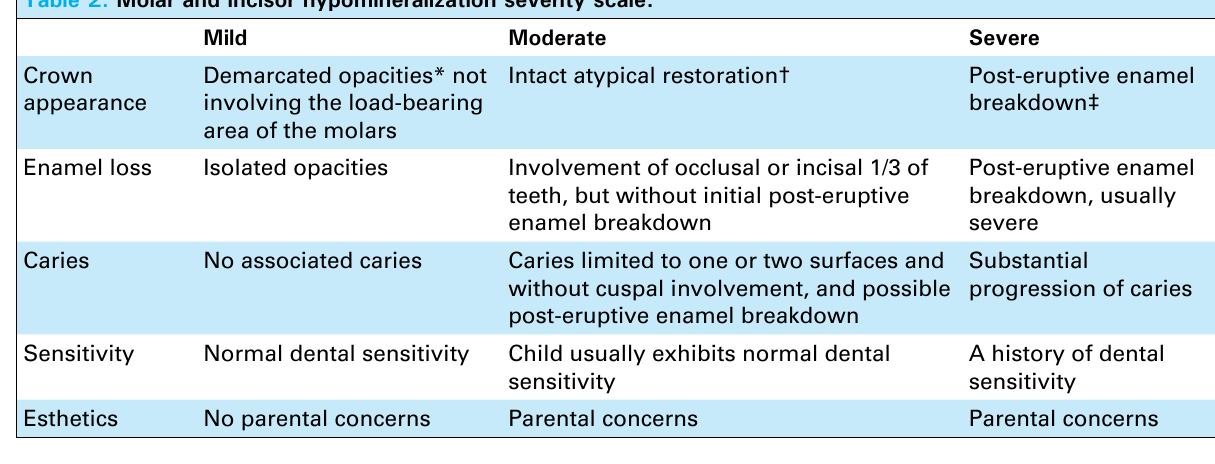
Table 3. Molar and incisor hypomineralization treatment need index.